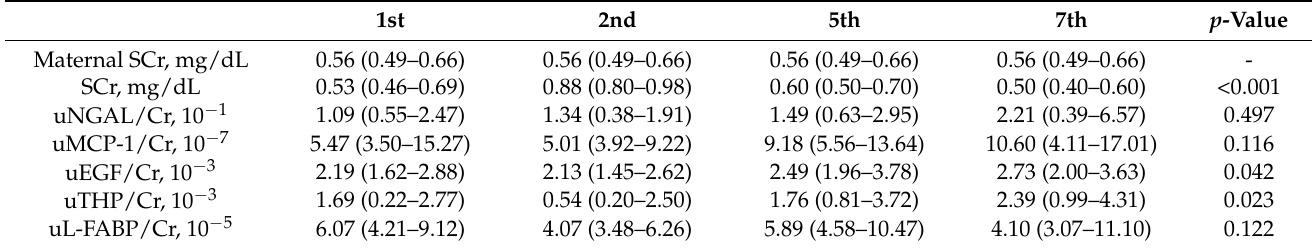
Table 2. Longitudinal changes in serum creatinine levels and urinary biomarkers during the first postnatal